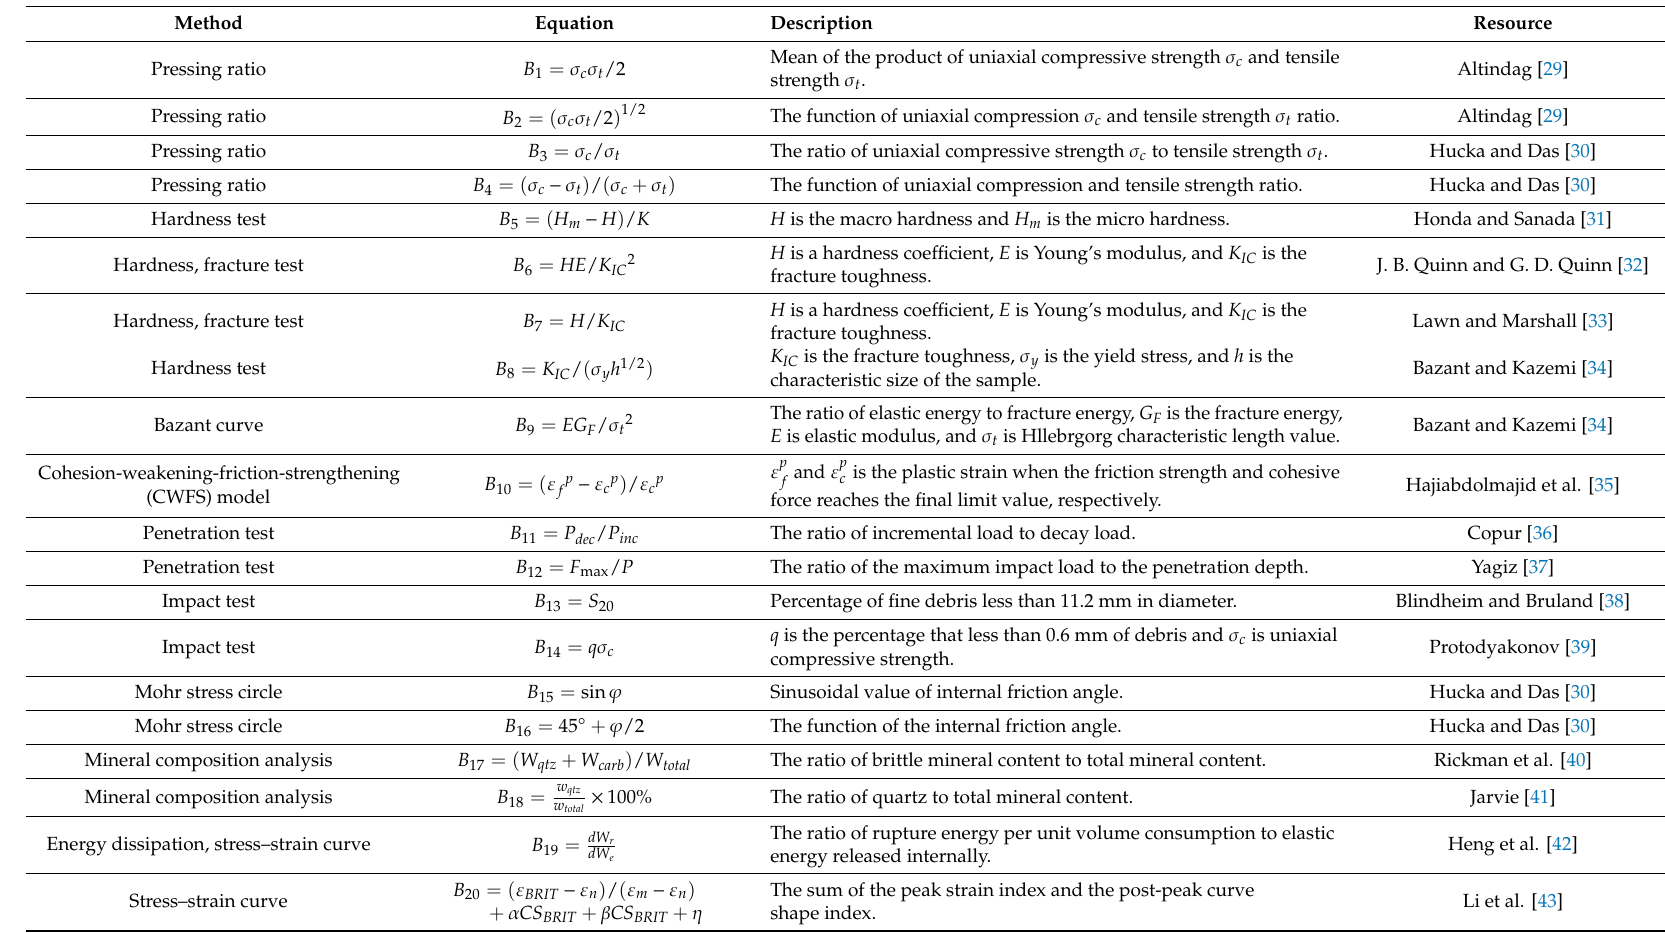
Table 2. Research table of brittleness evaluation methods from domestic and foreign